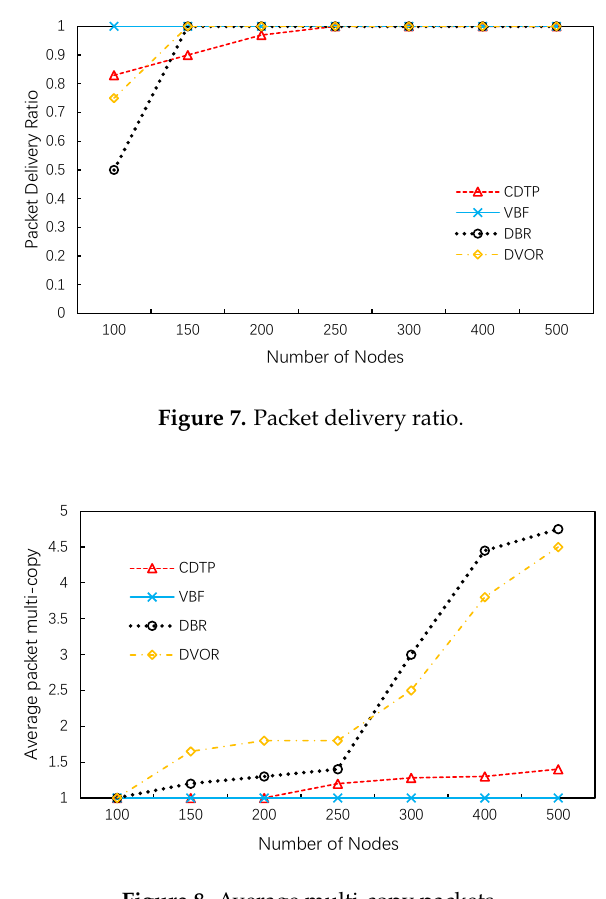
Figure 8. Average multi-copy